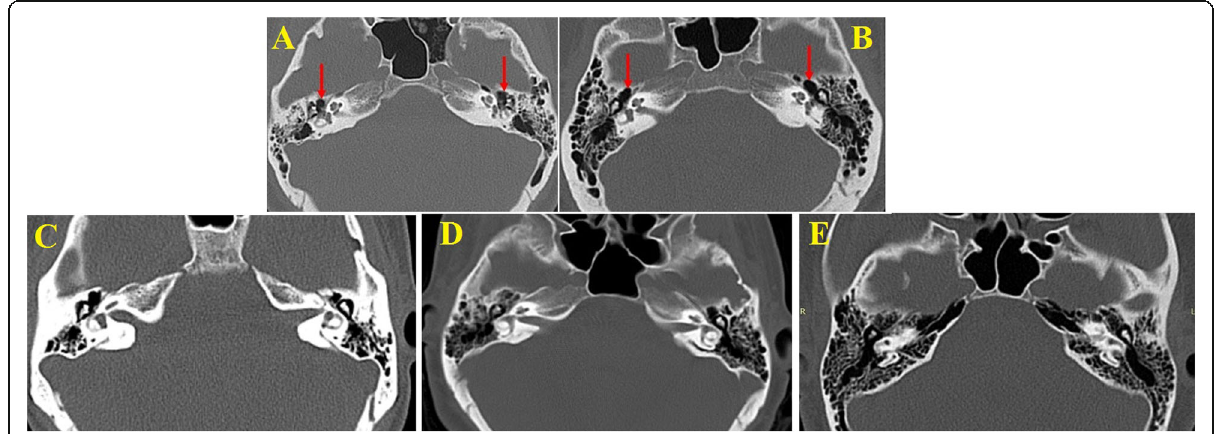
Fig. 1 a , b Supratubal recess (STR) (red arrows) in axial CT images and their relation to the ossicles and incudomalleal articulation. c The right and left STR formed of one cell. d The right STR formed of multi-cells while the left one formed of one cell. e Both the right and left STR) formed of